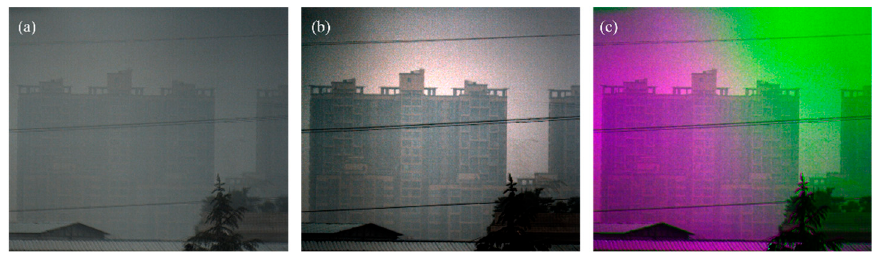
Figure 7. The dehazing experimental results. ( a ) Original intensity image; ( b) dehazed image using the current proposed method; and ( c ) dehazed image using our previously proposed method with the fixed bias parameters.